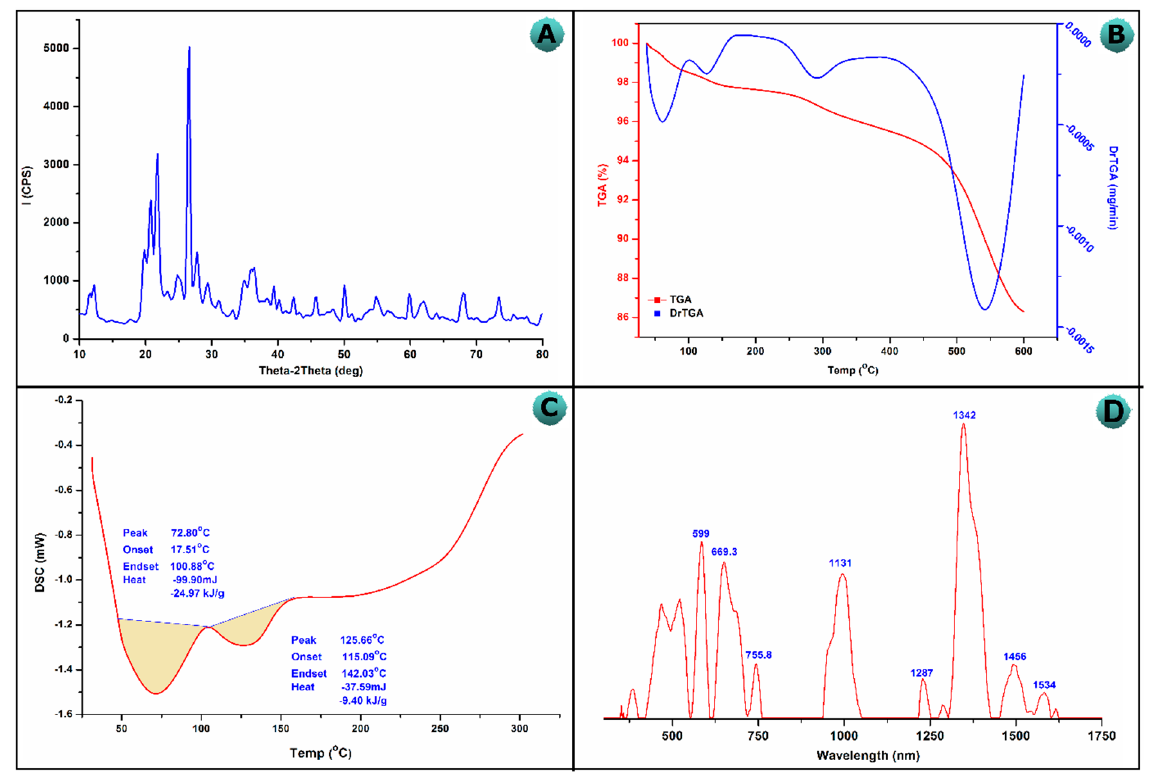
Figure 1. ( A ) XRD pattern, ( B ) TGA, ( C ) DSC, and ( D ) Raman spectra of the BT-An@Zetag composite.